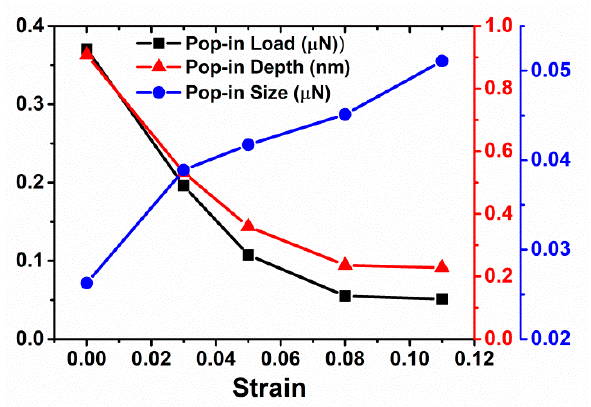
Figure 6. Pop-in load, depth, and size vs. prestrain for Cu with elastic deformation, indented with tip radius R = 7.5 nm.